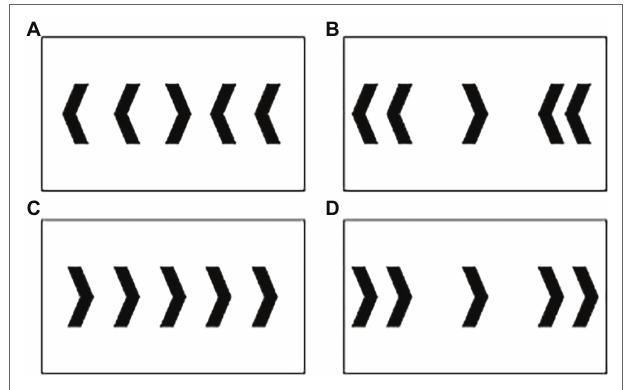
FIGURE 1 | Trials included in the modified Flanker task: (A) close- incongruent; (B) far-incongruent; (C) close-congruent; and (D) far-congruent. Note that this figure only shows trials indicating a right click, though right vs. left arrows were displayed in equal proportion during the